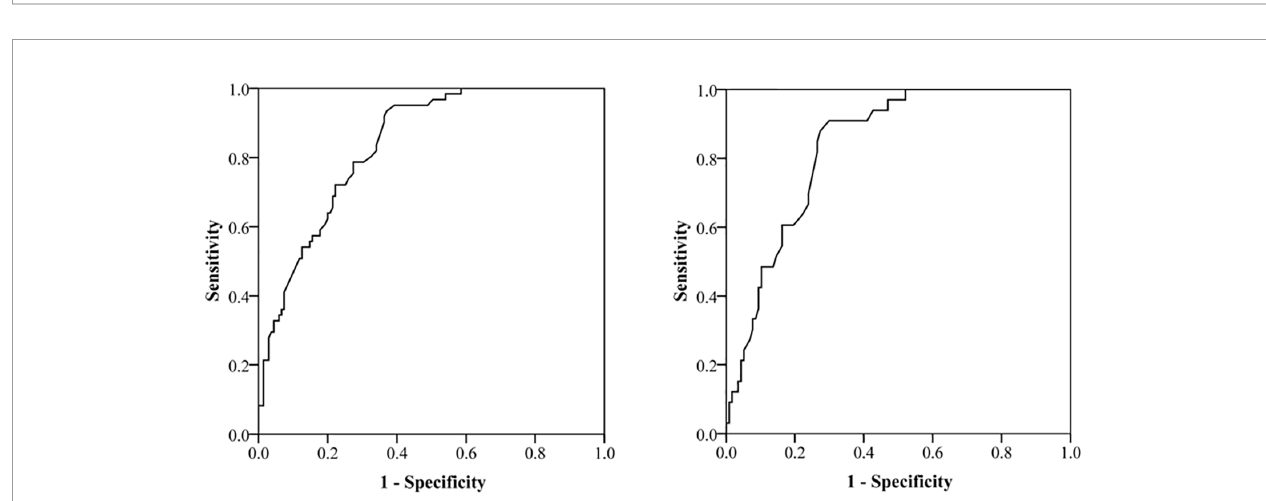
FIGURE 3 | Receiver operating characteristic (ROC) curve for evaluating the performance of nomograms in evaluating aggressive behavior in pancreatic neuroendocrine tumors (PNET). The area under the curve is 0.84 (95% CI, 0.78 – 0.89) for total population and 0.84 (95% CI, 0.78 – 0.89) for patients with G1/G2 PNETs.